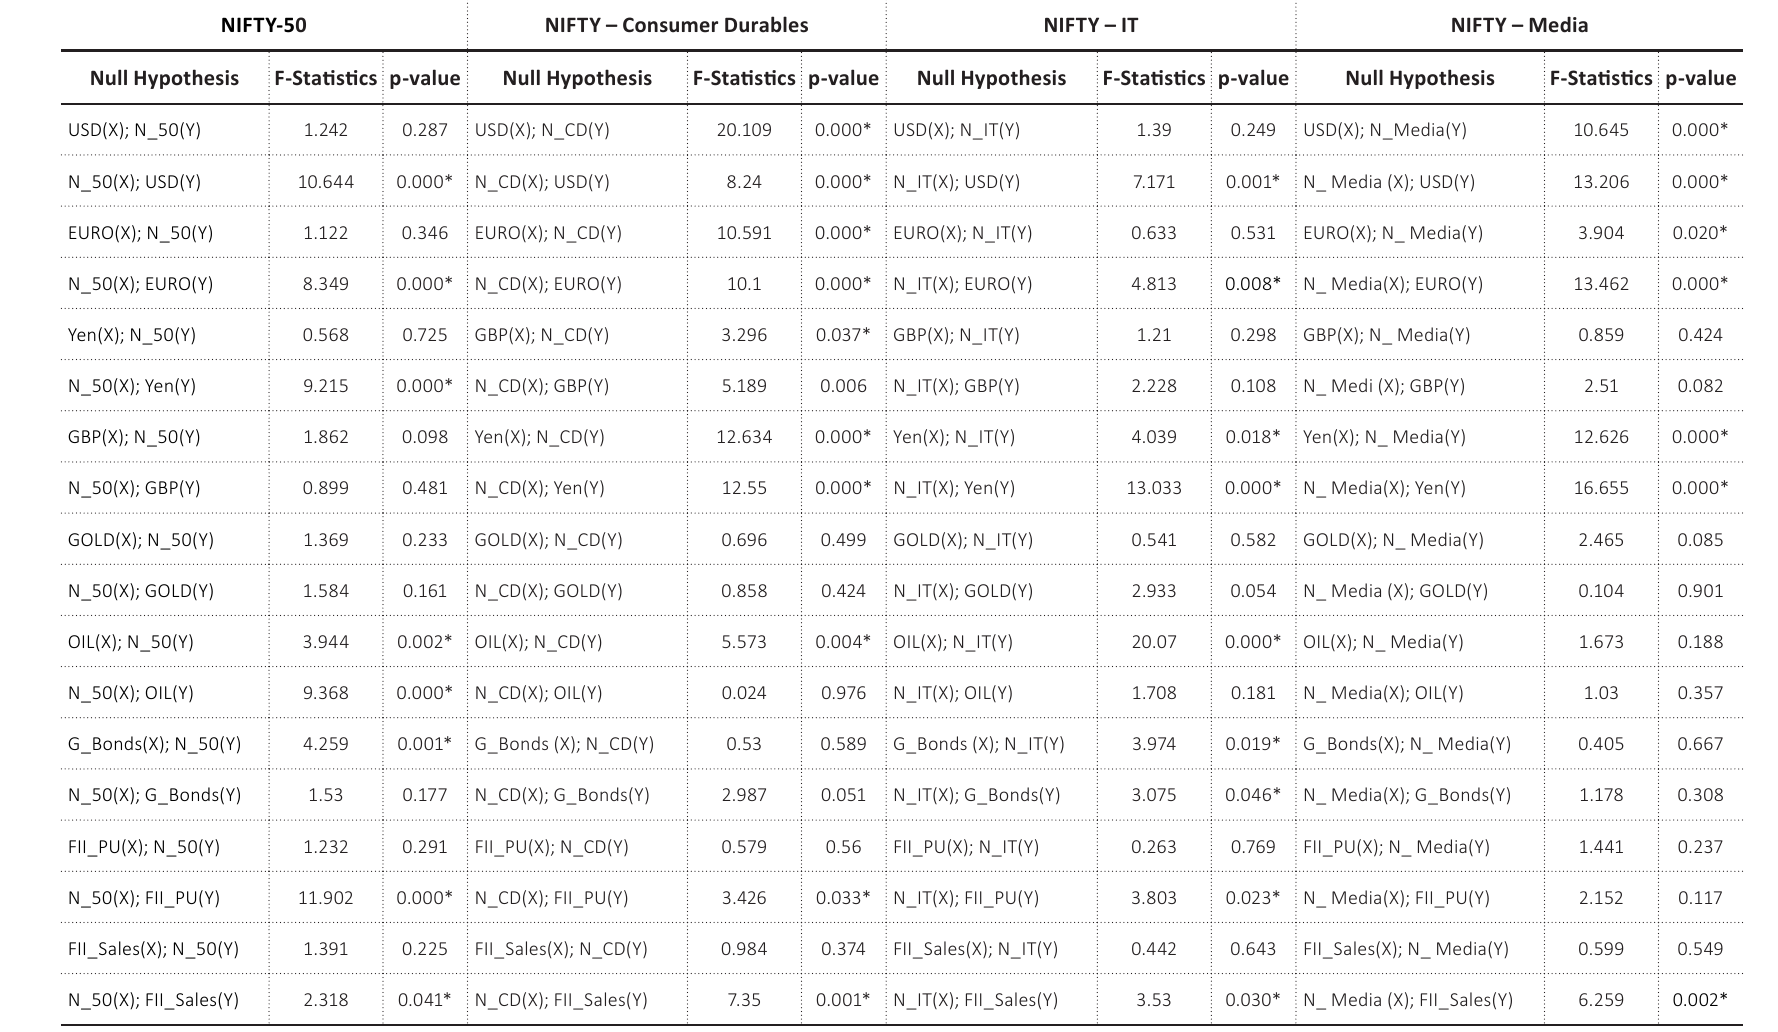
Table A1. Granger causality test results of NIFTY-50, NIFTY – Consumer Durables, IT, Media